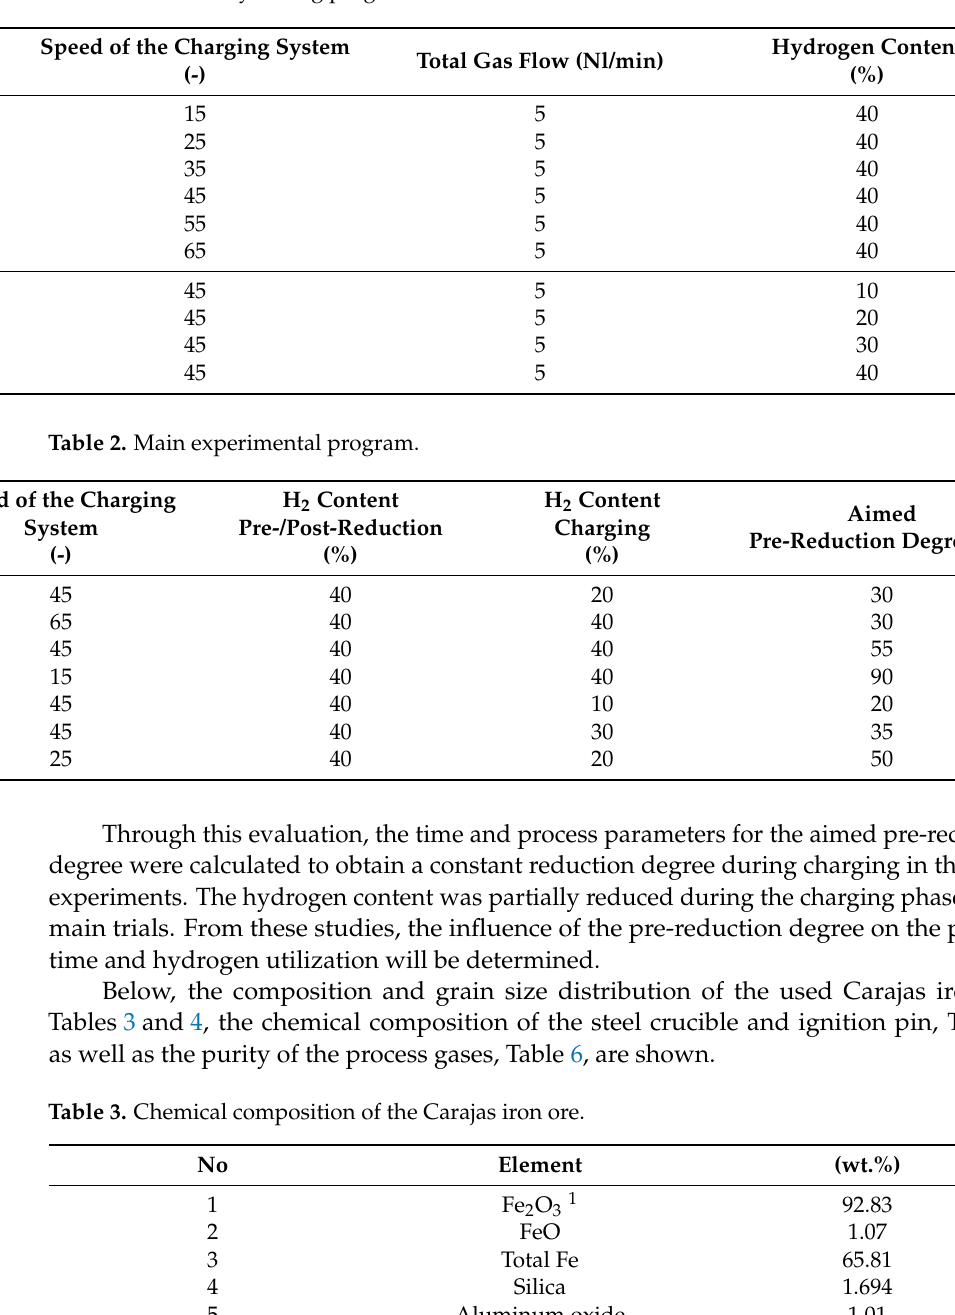
Table 1. Preliminary testing program.